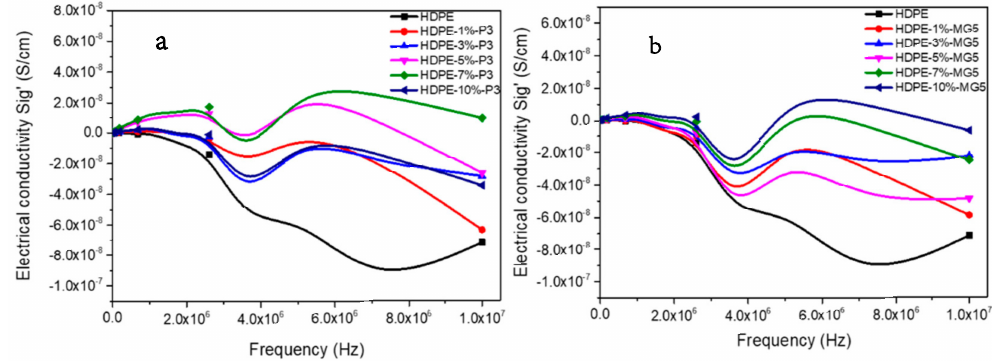
Figure 11. Electrical conductivity–frequency relationship of ( a ) HDPE-P3 and ( b ) HDPE-MG5 composites.